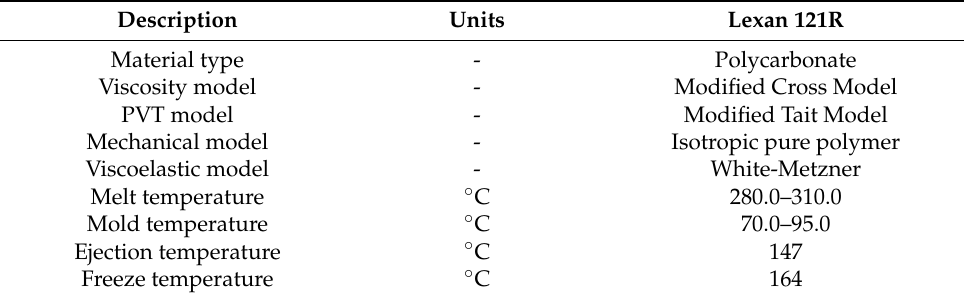
Table 5. Magnitude of the physical properties of the defined